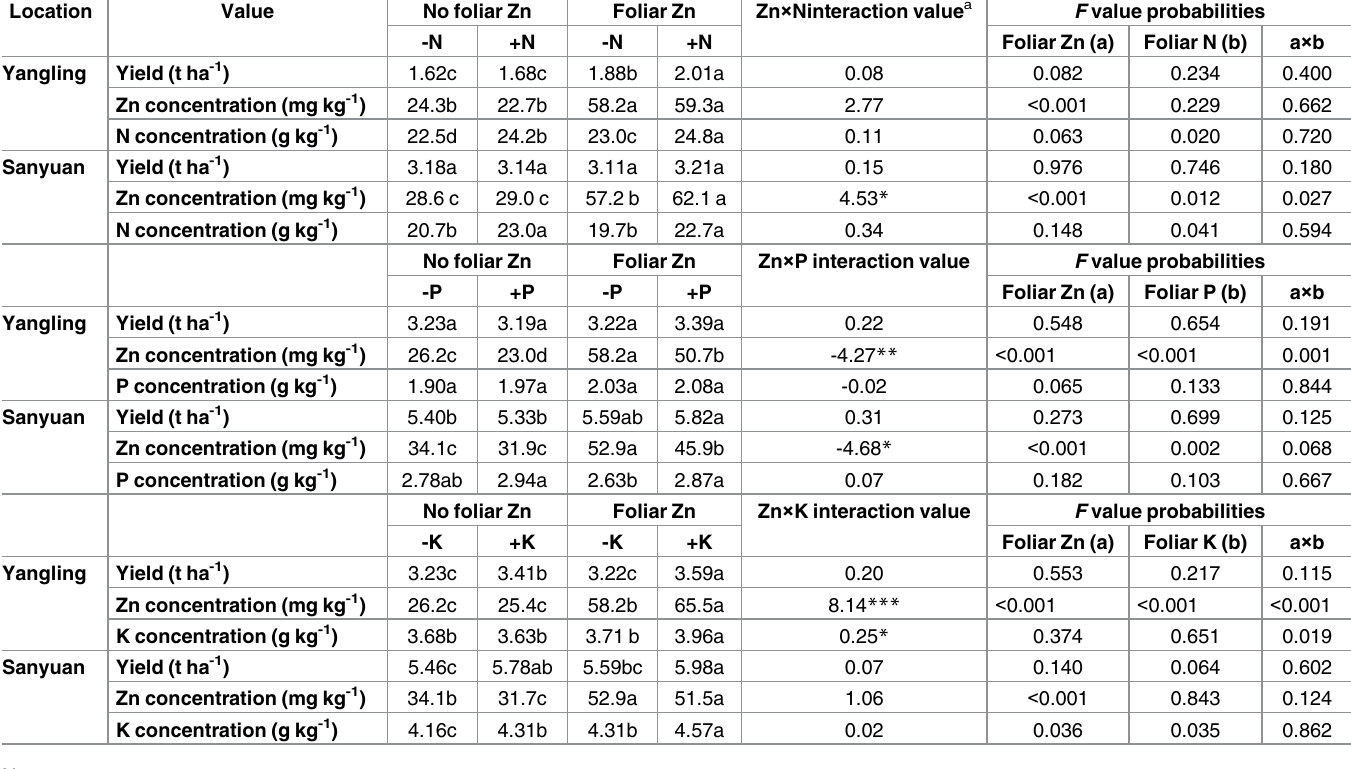
Table 3. Interactions between foliar-applied Zn and K, P, or N on Zn, K, P, or N concentrations in wheat grain.